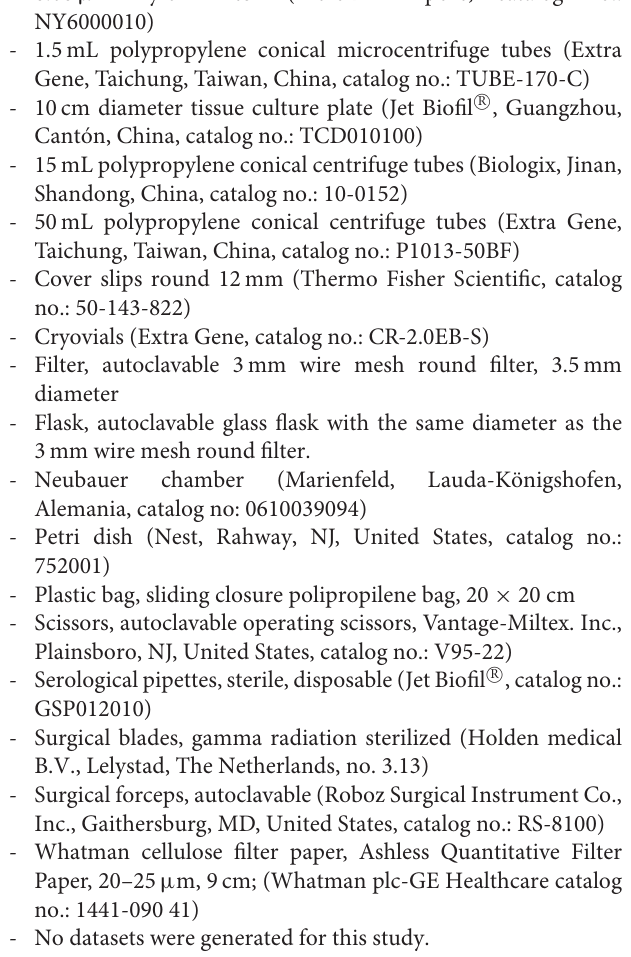
ATTENTION All solutions described are prepared with Milli-Q quality water (or